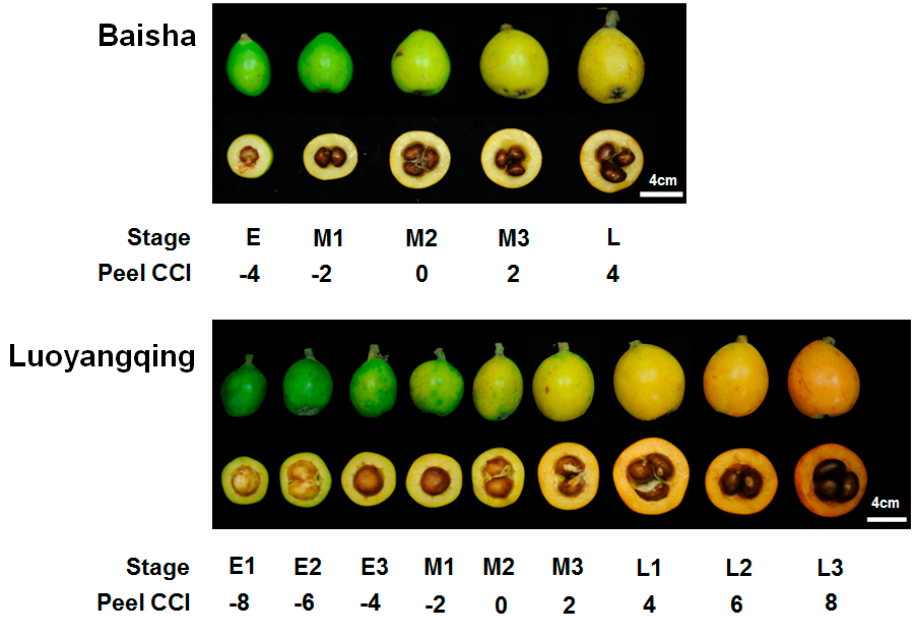
Figure 1. Appearance of Luoyangqing (LYQ) and Baisha (BS) loquat fruits at different maturity stages, as indicated by serial citrus color index (CCI) values for the peel. Bar = 4 cm.